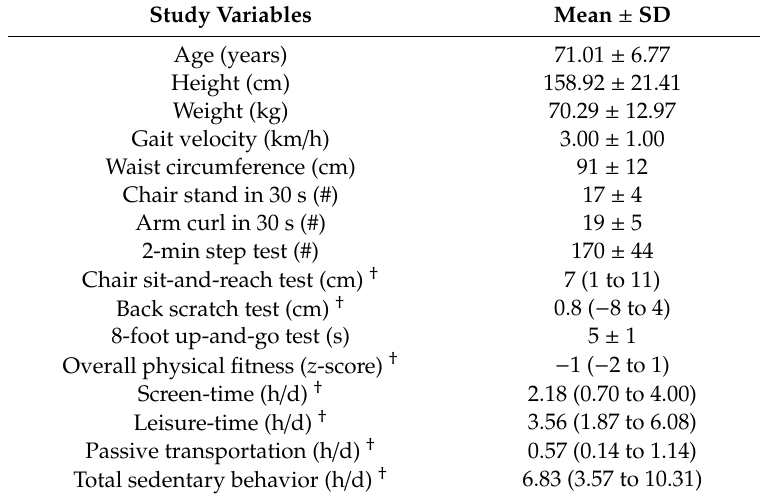
Table 1. Basic descriptive statistics of the study participants ( N = 120).